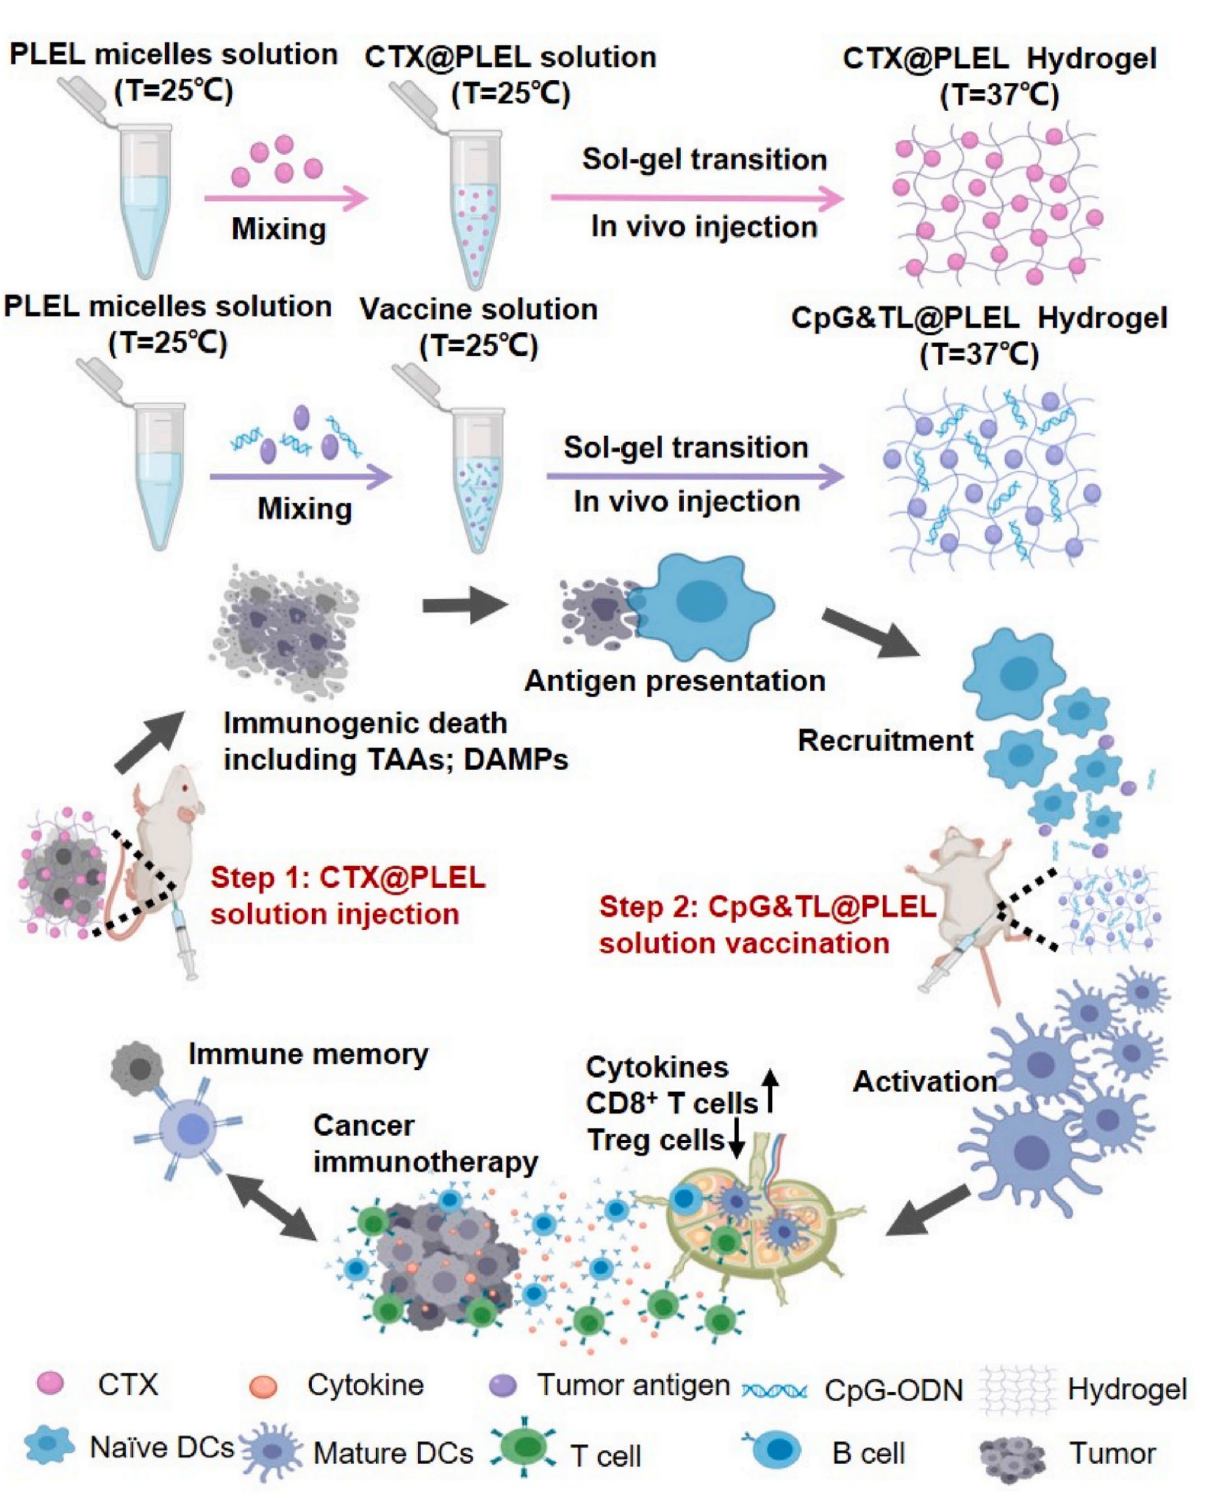
Figure 2. Schematic illustration of the PLEL-based combination strategy to amplify cancer immunotherapy. Adapted with permission from [114], published by Bioactive Materials, 2021.